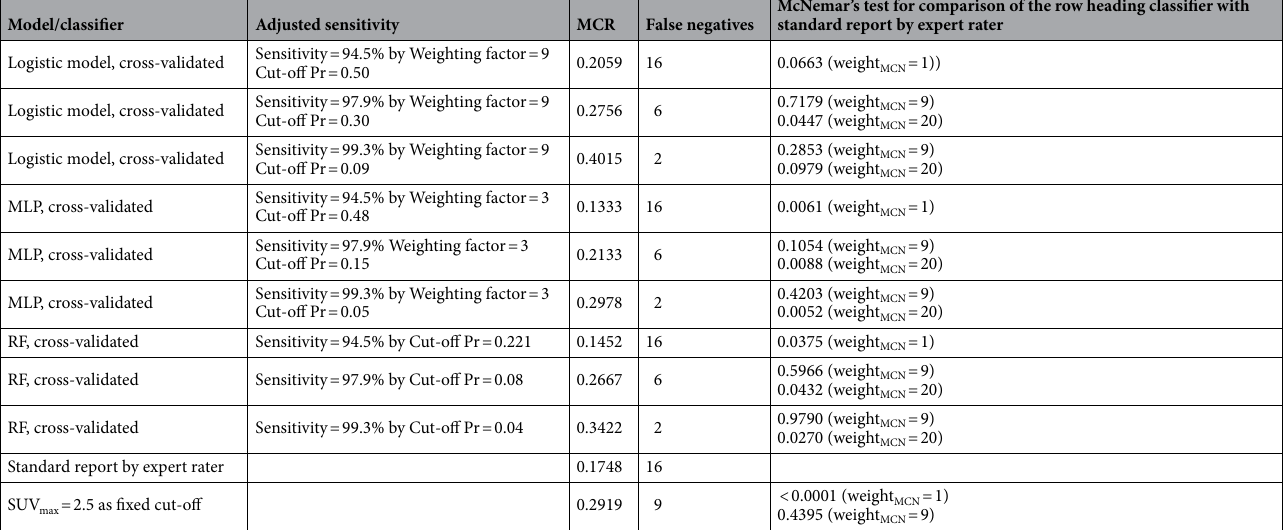
Table 4. Performance of the logistic model and two machine-learning models in comparison to the standard report. False negatives: number of EBUS-positive lymph nodes estimated to be EBUS-negative by the model. Weighting factors for EBUS-positive nodes compared to EBUS-negatives (weight = 1) were introduced to adjust the sensitivity of the MLP or logistic model similar to that of the specialist rater of 94.5% at a classification threshold of about 0.5. In addition, the cut-off probability for the classifier used to announce PET-positivity was chosen to adjust the sensitivity also to higher values of 97.9 and 99.3% as indicated in column 2. The McNemar’s test was used to compare the performance of the classifier in the respective row of the table with the standard report by the specialist rater. As the clinical consequences of false positives and negatives are different, a weighted McNemar’s test was used and the weighting factors for EBUS positive lymph nodes using this test (weight MCN ) relative to those of EBUS negative nodes are indicated. Error rate: number of misclassifications over the 675 assessed lymph nodes. MCR misclassification rate, MLP multilayer perceptron neural network; RF Random forest.